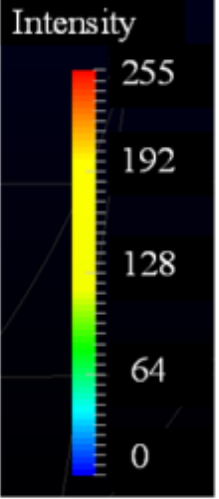
Figure 15. Intensity of point cloud map.